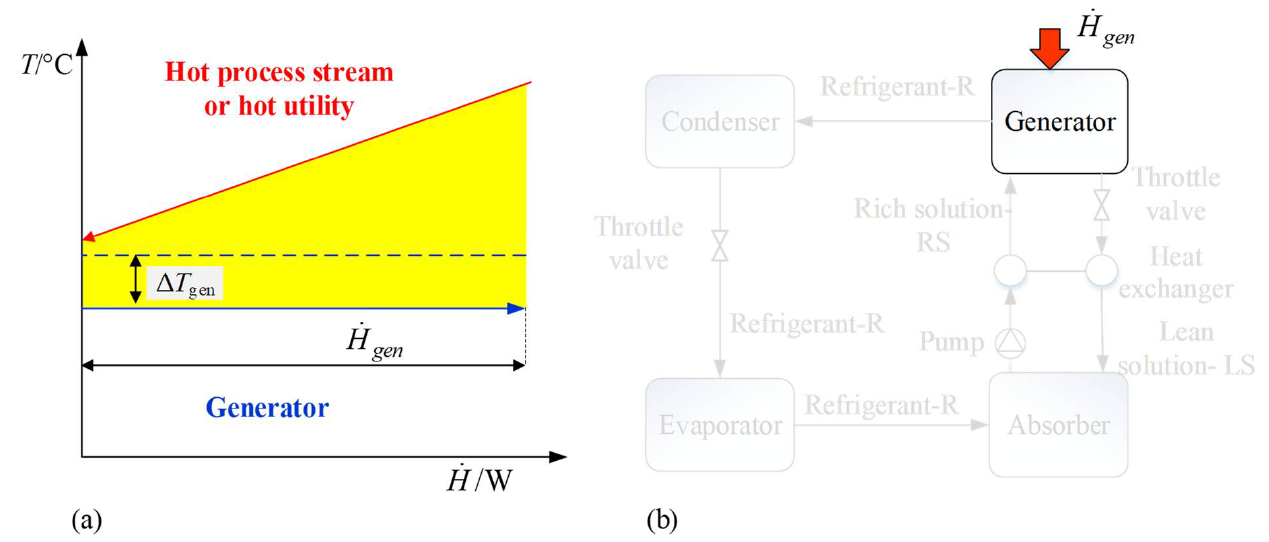
Figure 5. ( a ) Heat integration of generator represented by a composite curve and ( b ) presentation of generator as a part of AC cycle.